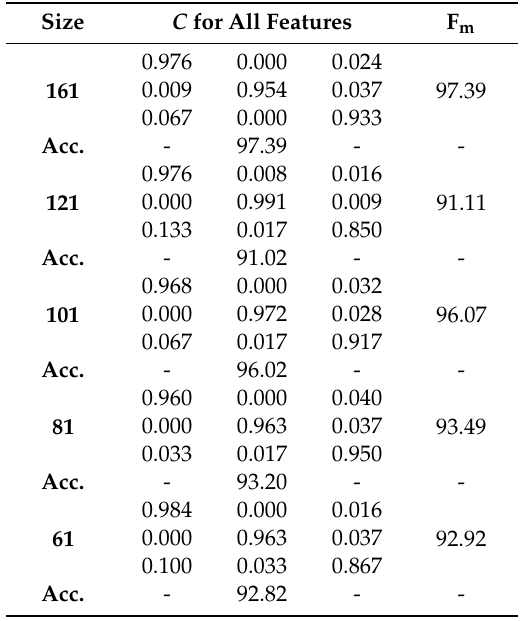
Table 8. Performance of the decision tree (DT) classifier.